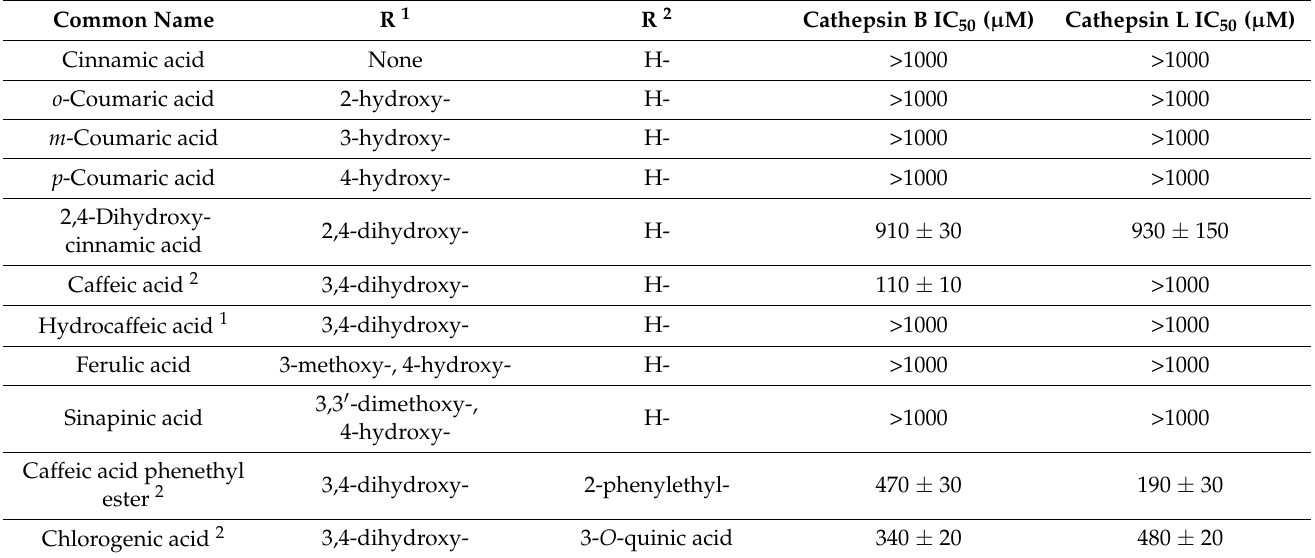
Figure 1. ( a ) The cinnamic acid scaffold; ( b ) chemical structures of cinnamic acid derivatives that acted as inhibitors of cathepsins B and/or L. Table 1. Determined IC 50 values of all tested compounds: The activity of cathepsin B was measured using the substrate Z-Phe-Arg-AMC at [S] = K m, and the activity of cathepsin L was measured using the substrate Z-Leu-Arg-AMC at [S] = 2 × K m . All